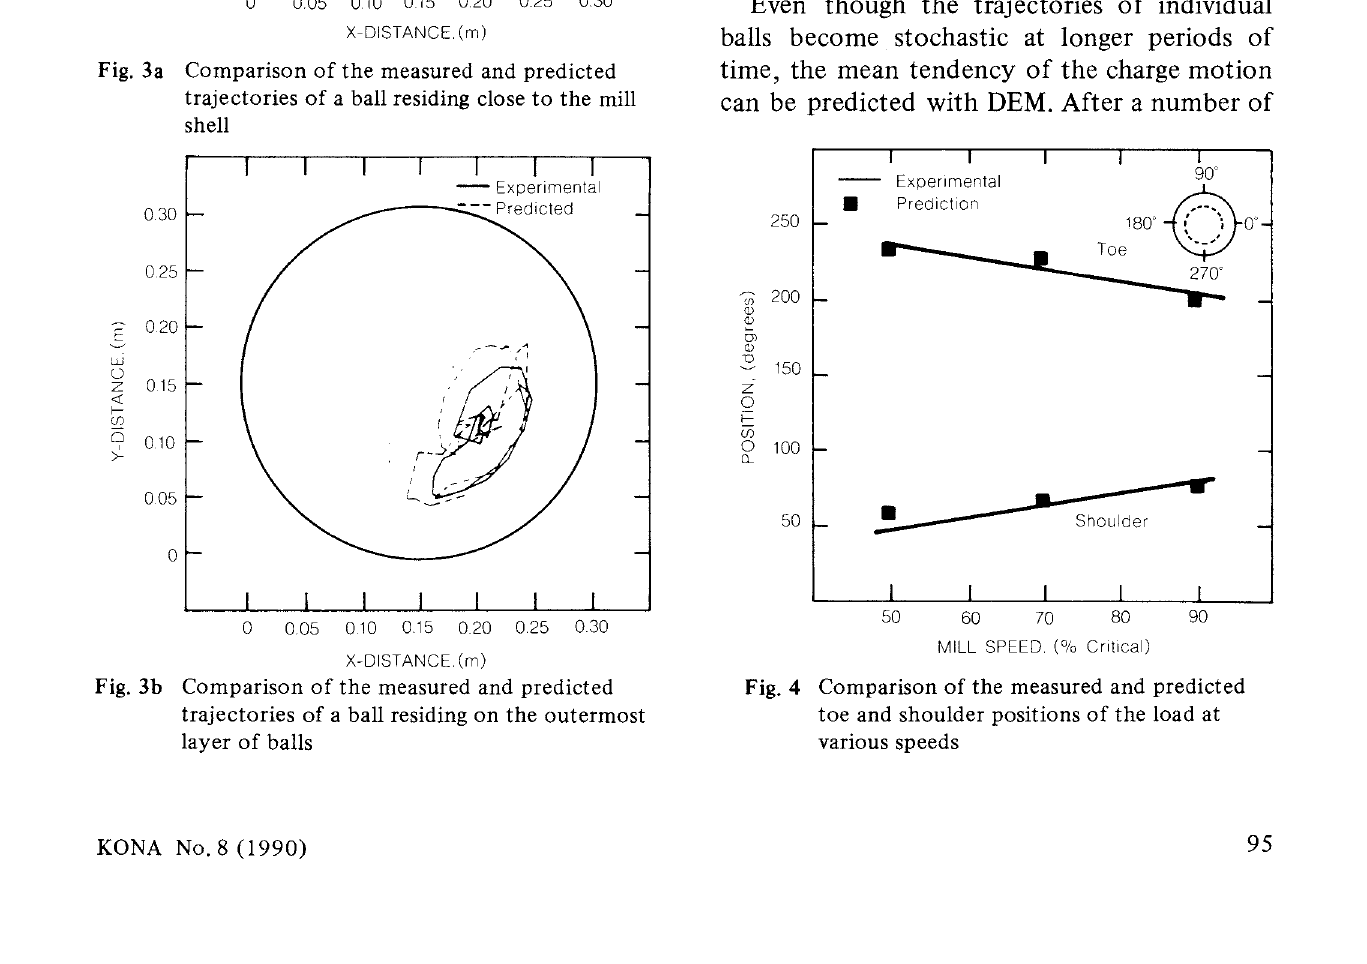
Fig. 3a Comparison of the measured and predicted trajectories of a ball residing close to the mill shell